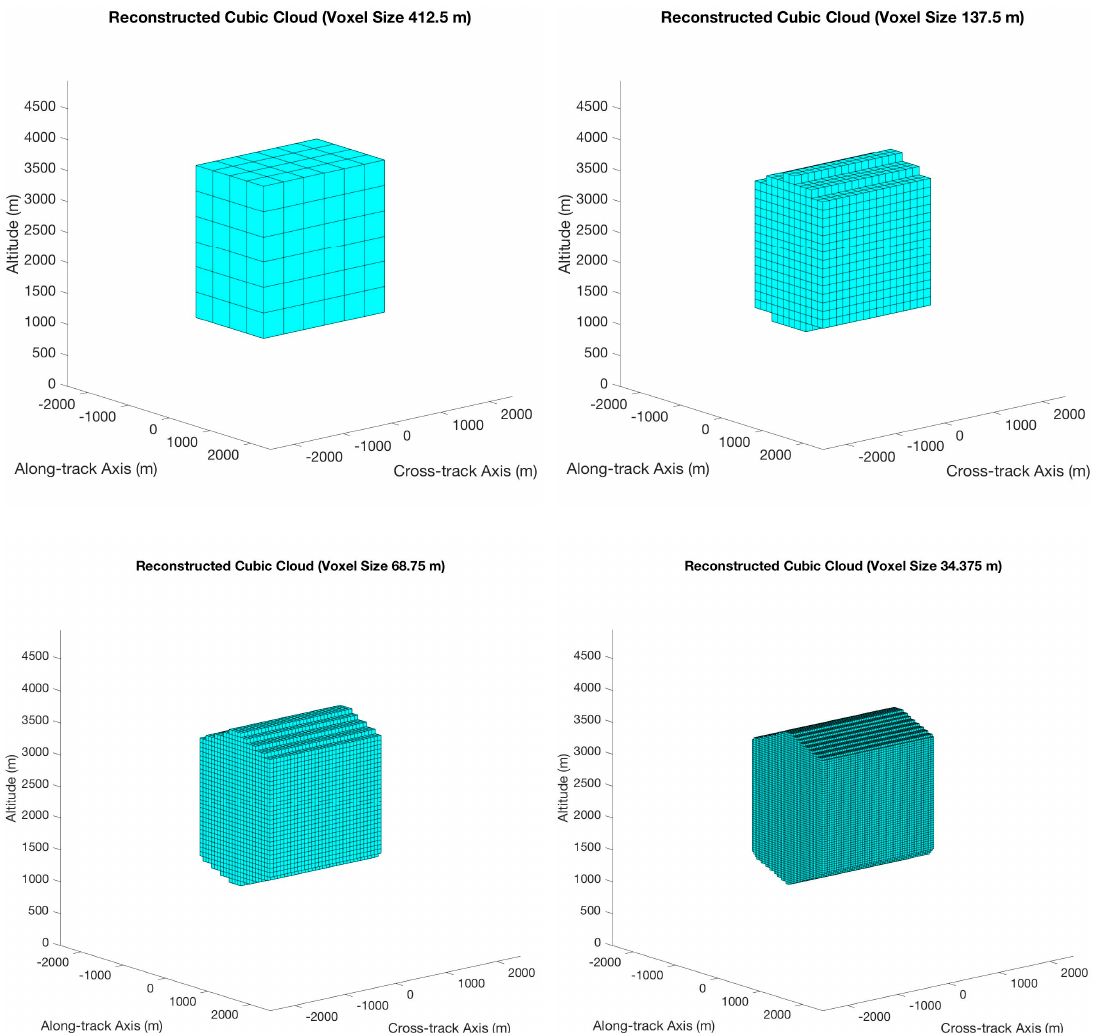
Figure 4. An example set of reconstructed cloud volumes for different reconstruction voxel resolutions. Here, the original cubic cloud has a length of 1650 m. The image pixel resolution of 275 m is used. All plots are to scale.